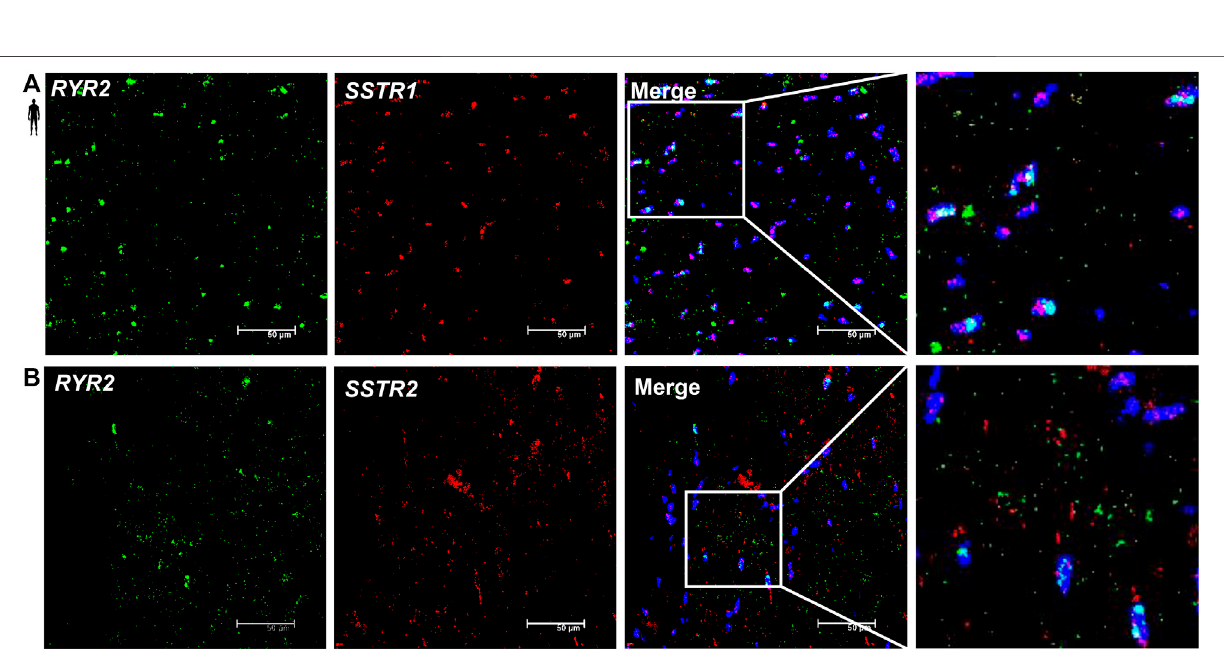
Frontiers in Pharmacology |